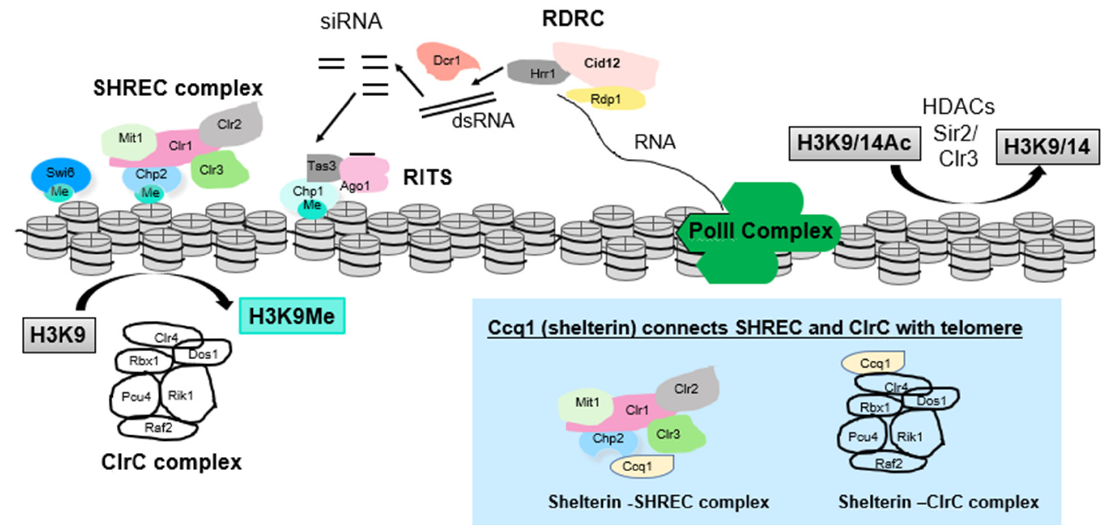
Figure 2. Complexes involved in heterochromatin assembly at subtelomeres in S. pombe . Complexes include (1) factors involved in the RNAi pathway (Dcr1, which generates siRNAs; RDRC complex, which amplifies RNAi signal; and RITS, which is the RNAi-effector complex and includes Ago1, which can bind siRNA to direct cleavage of nascent transcripts as well as bind to H3K9me), (2) ClrC complex, which directs H3K9 methylation, (3) HDACs such as Clr3, which resides in the SHREC complex that can remodel chromatin, and Sir2. At telomeres, (see blue box) the Ccq1 protein component of shelterin associates with SHREC and with ClrC to link heterochromatin assembly to telomere control. Curved arrows represent H3K9 methylation by ClrC complex and deacetylation of H3K9ac/K14ac by HDACs Sir2 and Clr3. Straight arrows depict RDRC-mediated generation of dsRNA from RNA Pol II transcript, cleavage of dsRNA by Dcr1 to form siRNAs and (not shown in detail) steps leading to eventual assembly of RITS loaded with siRNA.